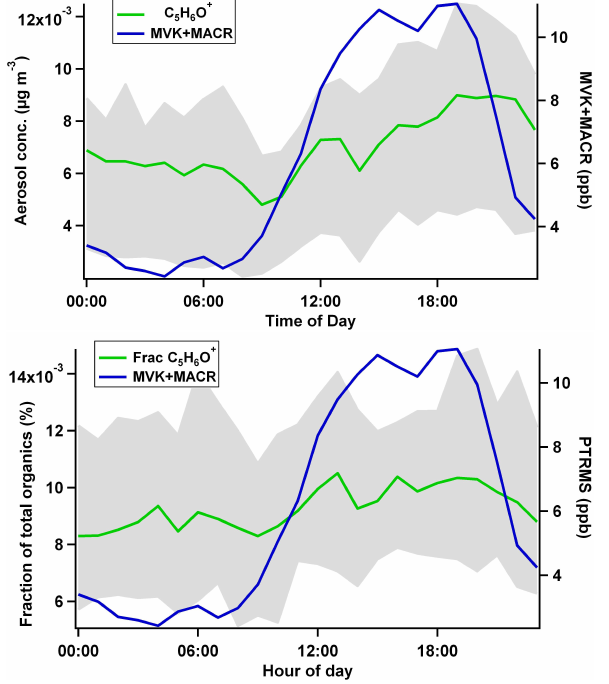
Fig. 4. Diurnal averages of (a) C 5 H 6 O + signal and MVK+MACR and (b) fraction of organic signal at C 5 H 6 O + and MVK+MACR. C 5 H 6 O + interquartile ranges are shown by shaded regions.